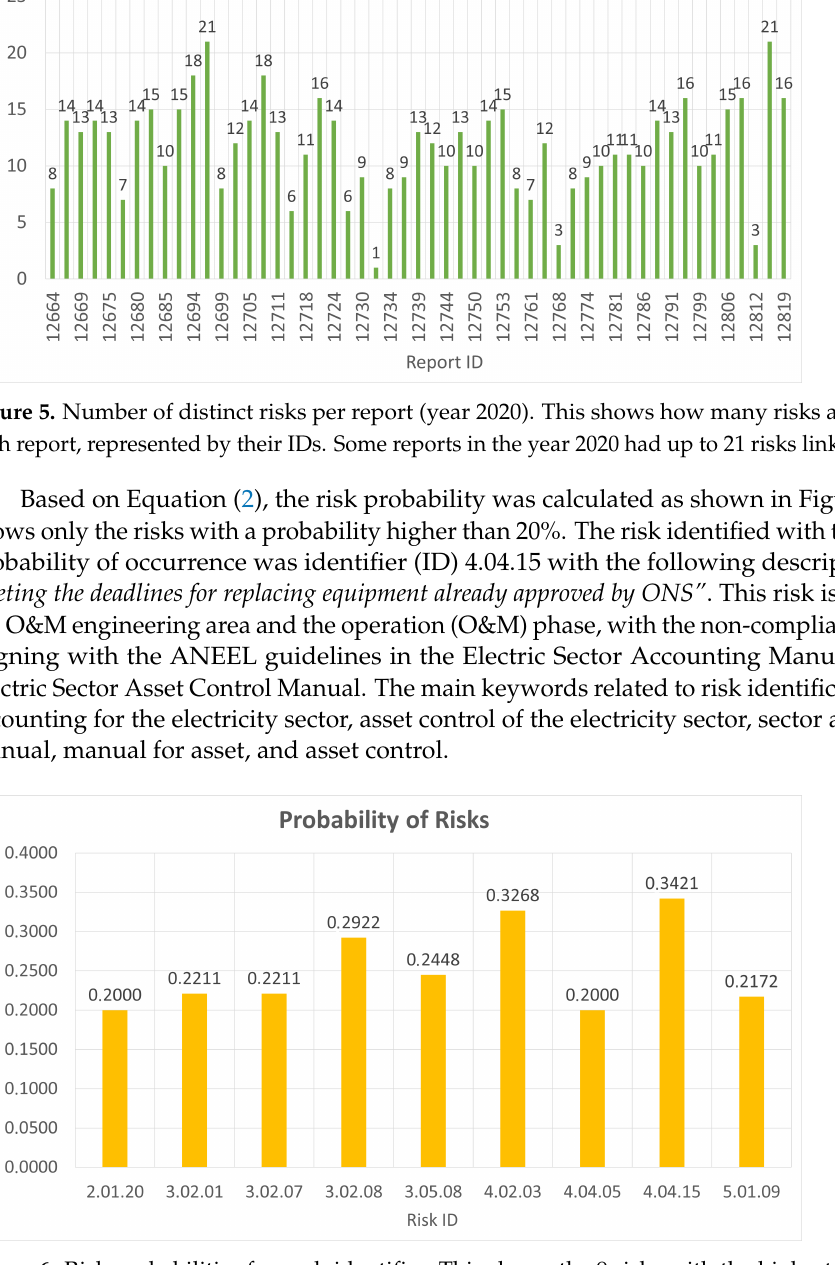
Figure 6. Risk probabilities for each identifier. This shows the 9 risks with the highest probability. Probabilities were calculated based on Equation